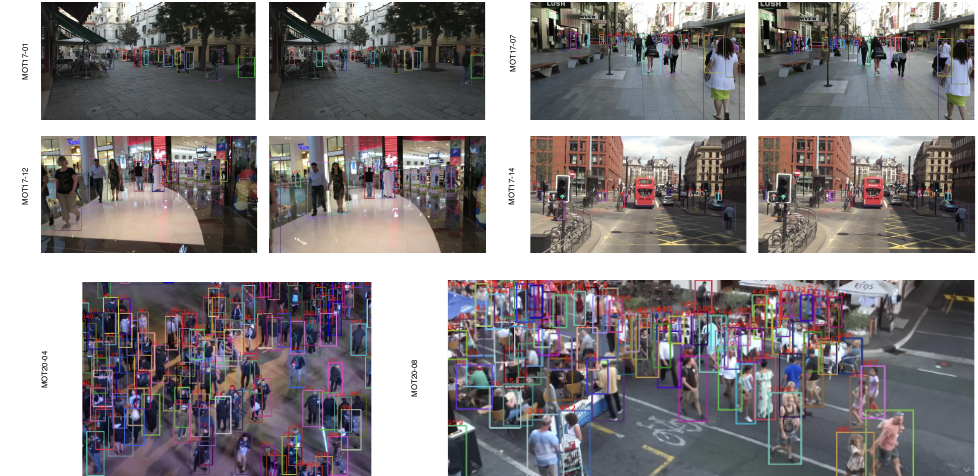
Figure 4. Visualization of tracking results on MOT17 and MOT20 test datasets. Boxes of the same color and numbers in the upper left corner of the box indicate the same tracking target. The method proposed in this paper has visible and effective effects on object density and